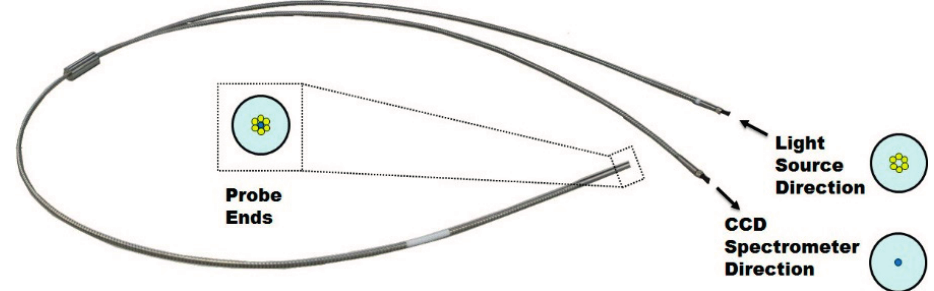
Figure 5. A photo of the bifurcated fiber optic probe used for reflectance measurement with the visible and near infrared